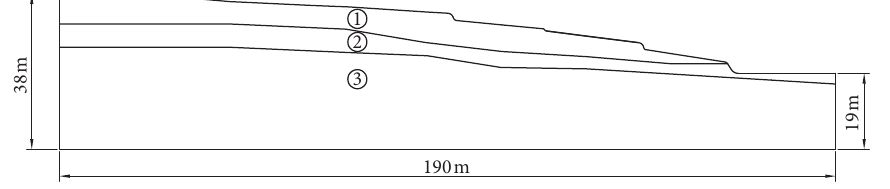
Figure 10: Schematic of the original model.